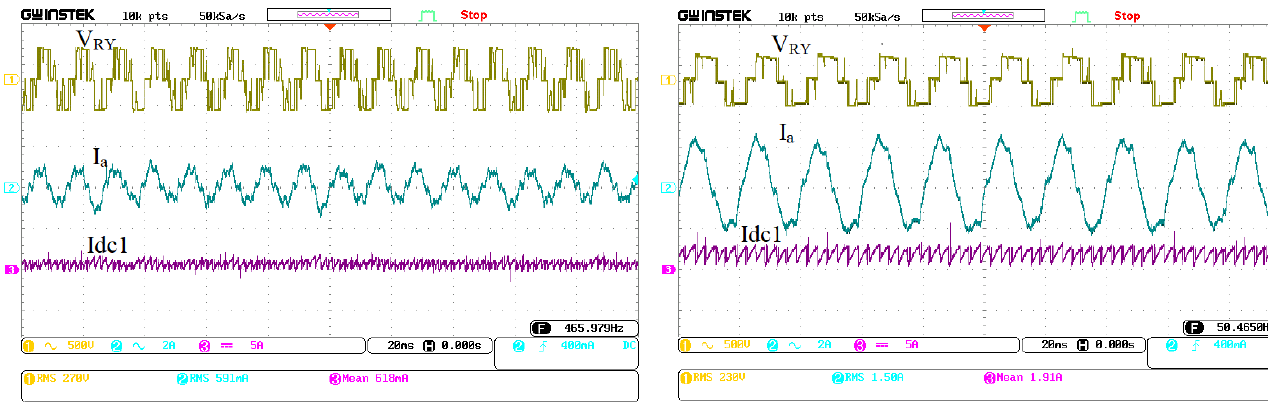
Figure 11. Experimental voltage, ac input current, and dc output current at low speed and maximum speed when power is supplied through the main source.